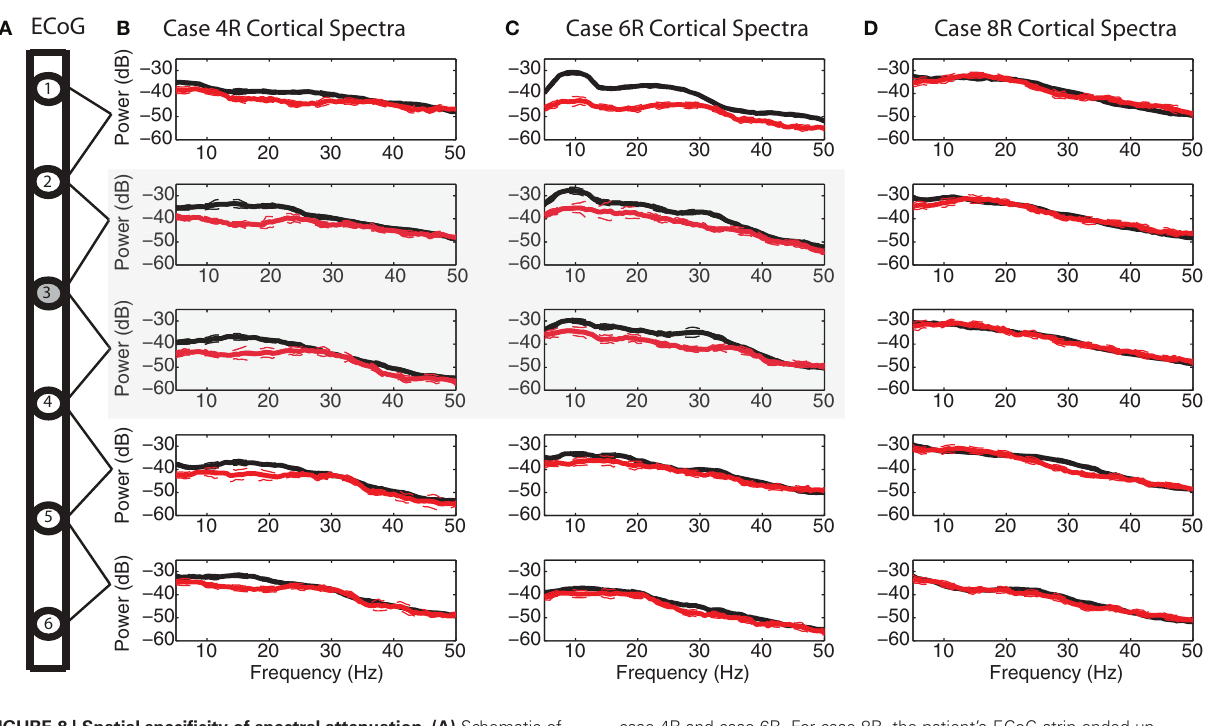
FIGURE 8 | Spatial specificity of spectral attenuation. (A) Schematic of electrode array. Power spectral densities with 95% confidence limits before (black) and during (red) 2.5V DBS within the STN for each ECoG bipolar pair for (B) case 4R, (C) case 6R, and (D) case 8R. Cortical electrode #3 was placed over the efferent projection site of the hyperdirect pathway for both